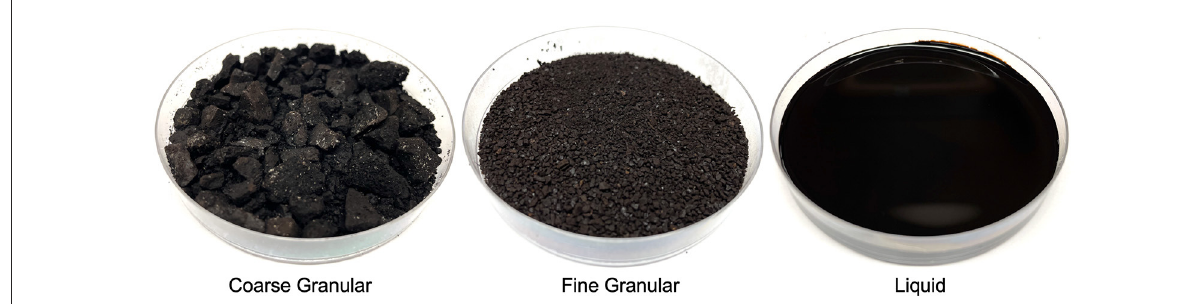
FIGURE1 Different forms of raw and extracted humic-based products (Humalite).